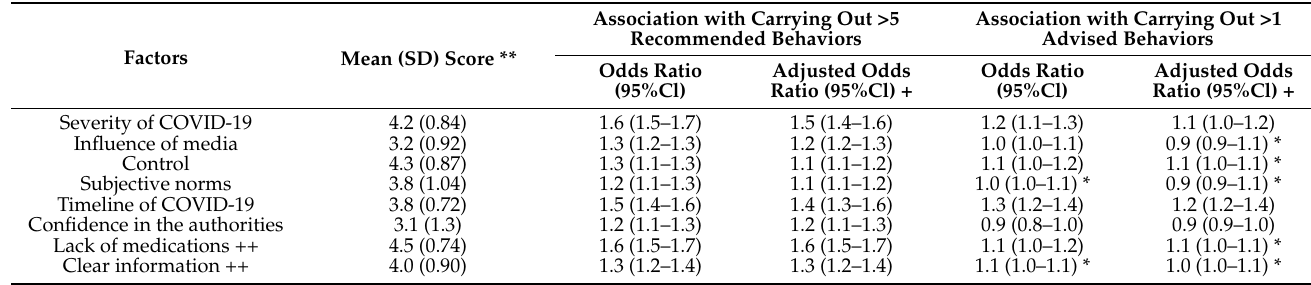
Association with Carrying Out >5 Recommended